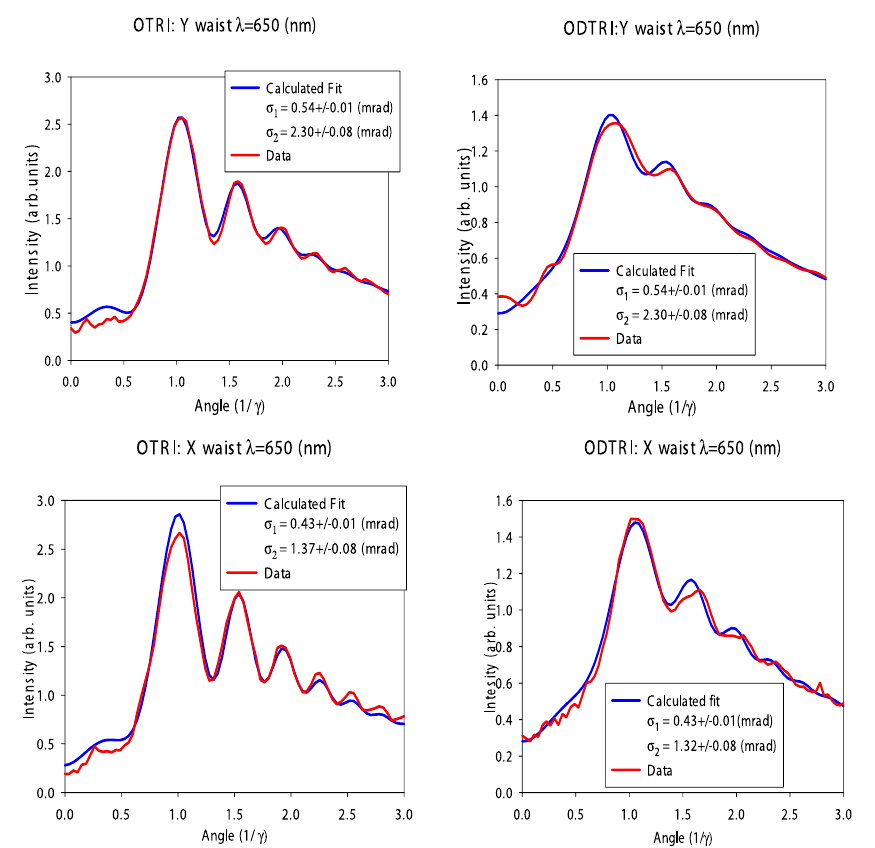
FIG. 7. (Color) OTRI and ODTRI fits and data taken with a 650 nm (cid:13) 10 nm optical bandpass filter at vertical ( Y ) and horizontal ( X ) beam